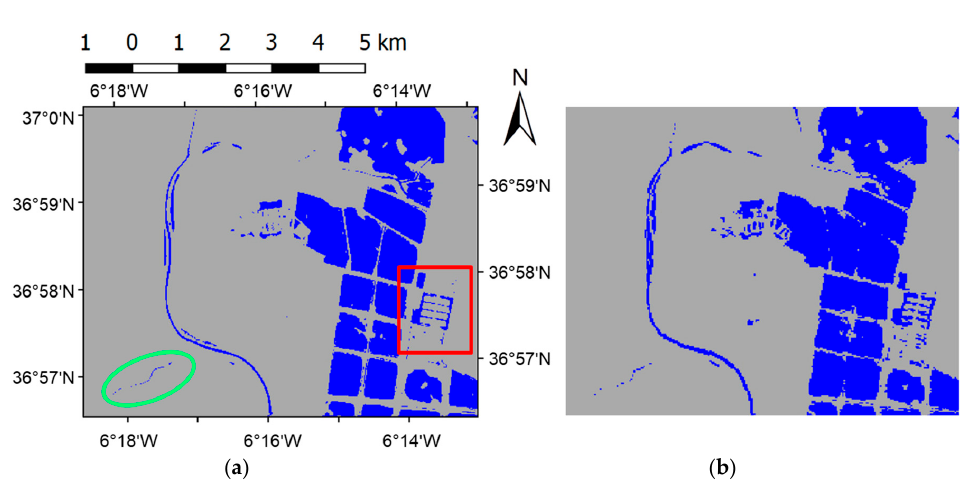
12. Figure 12. Zoomed region of ( a ) the inundation map generated on 25 August 2016 using the unsupervised approach and ( b ) the Landsat inundation map on 25 August 2016. The green ovals enclose small water covered areas, and the red square encloses a region that shows a more precise registration of the boundary conditions between water and land. The coordinate grid of the left and right zoomed regions is the same; thus, it is drawn only around the middle one.